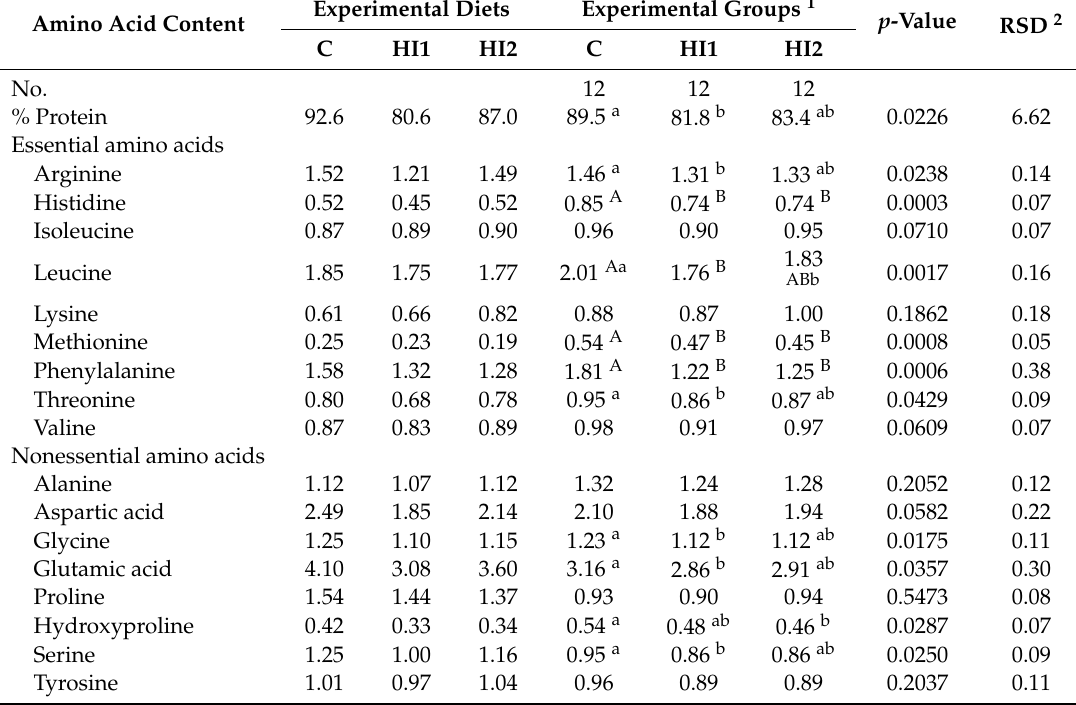
Table 4. E ff ect of the dietary inclusion of Hermetia illucens dried larvae farmed on di ff erent growth substrates (HI1, HI2) on the amino acid content (g / 100 g meat) of broiler quails’ breast meat. Amino Acid